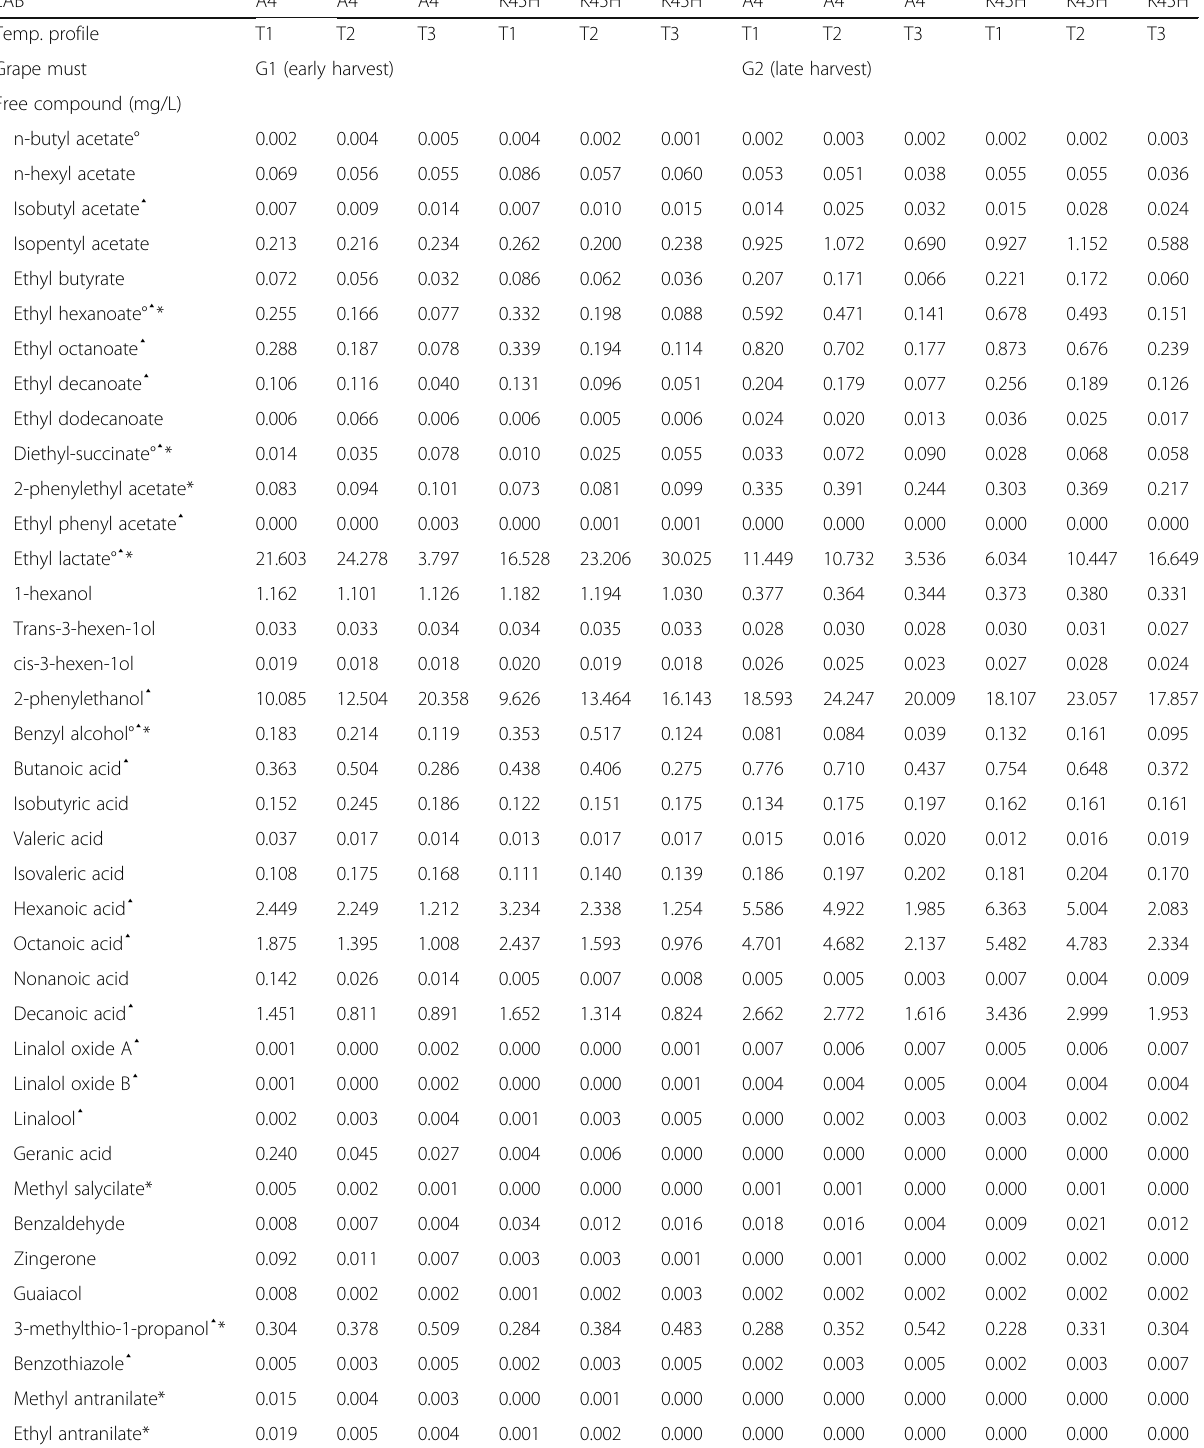
Table 3 Profile of free and bounded volatile compounds, determined by GC-MS, of wines obtained by simultaneous fermentation of S. cerevisiae and L. plantarum or O. oeni at different temperature profiles. T1 test: 16/22 °C in 3 days, B. T2 test: 18/24 °C in 3 days, and C. T3 test: 22/32 °C in 5 days. °Differences are statistically significant both in terms of bacteria strain and temperature profile effect (two-way ANOVA test, p = 0.05). ▴ Differences are statistically significant in terms of temperature effect (two-way ANOVA test, p = 0.05). *Differences are statistically significant in terms of strain effect (two-way ANOVA test, p =